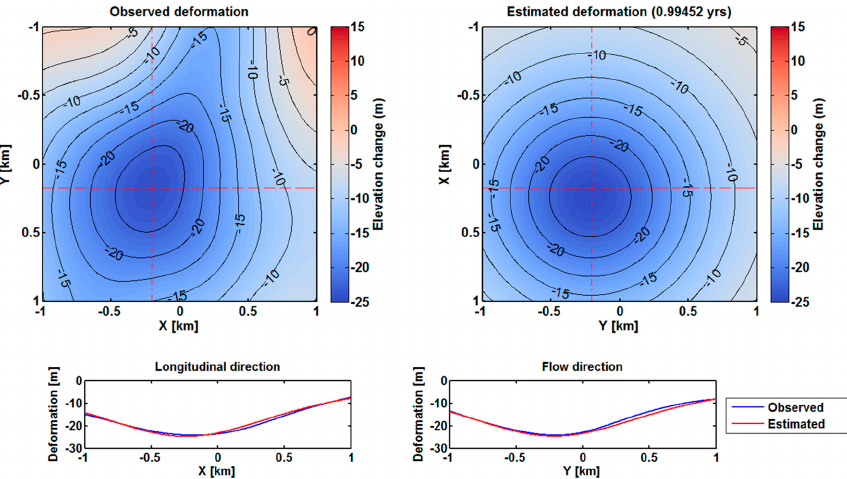
Figure 6. Comparison between the observed and estimated deformations from the modified deformation model after the global optimization process during 2012–2013, with the setting time as the actual elapsed time. The minimum RMS difference between the two deformation maps was 2.11 m. Profiles in the longitudinal and along ‐ flow directions are plotted along the red dashed and dot ‐ dashed lines, respectively.